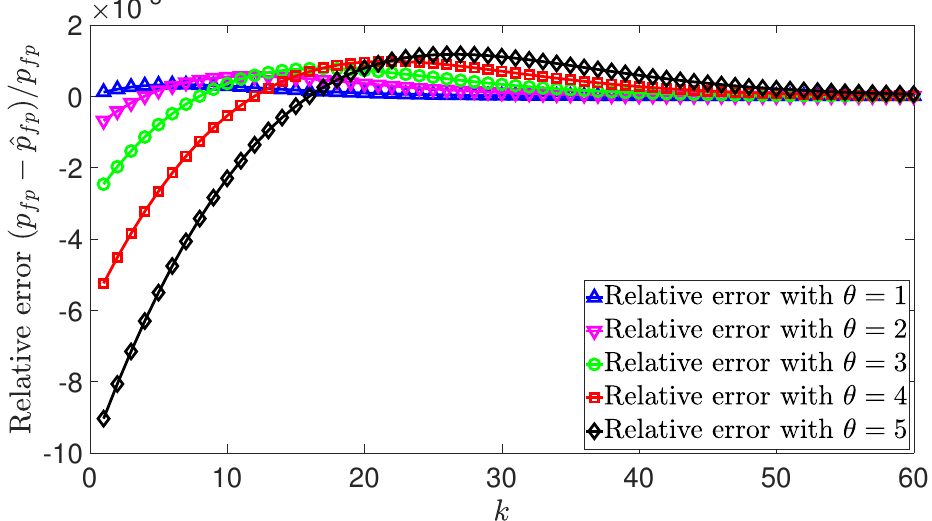
Figure 2. Plot of relative error between exact and approximate false positive probabilities with θ = 1 to θ = 5 vs. the number of hash functions k . n = 1000 and m = 4000 are used in this plot, and larger values of n and m result in slightly lower relative